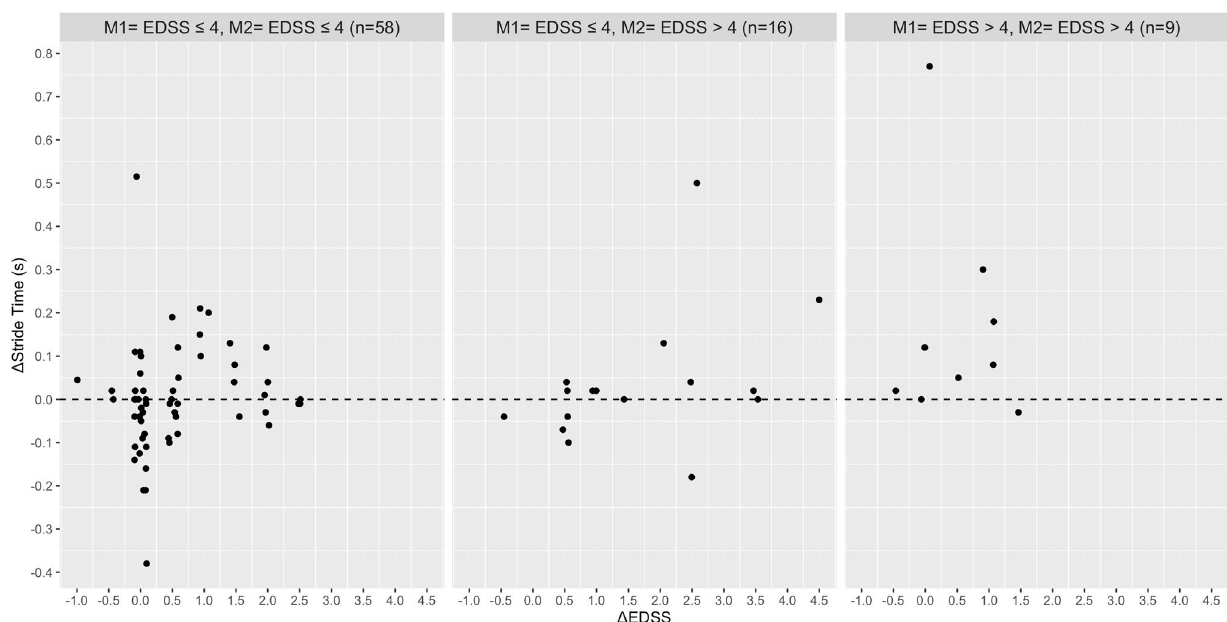
Figure 3. Relationship between the absolute change in stride time with absolute change in the EDSS score according to disability subgroups.